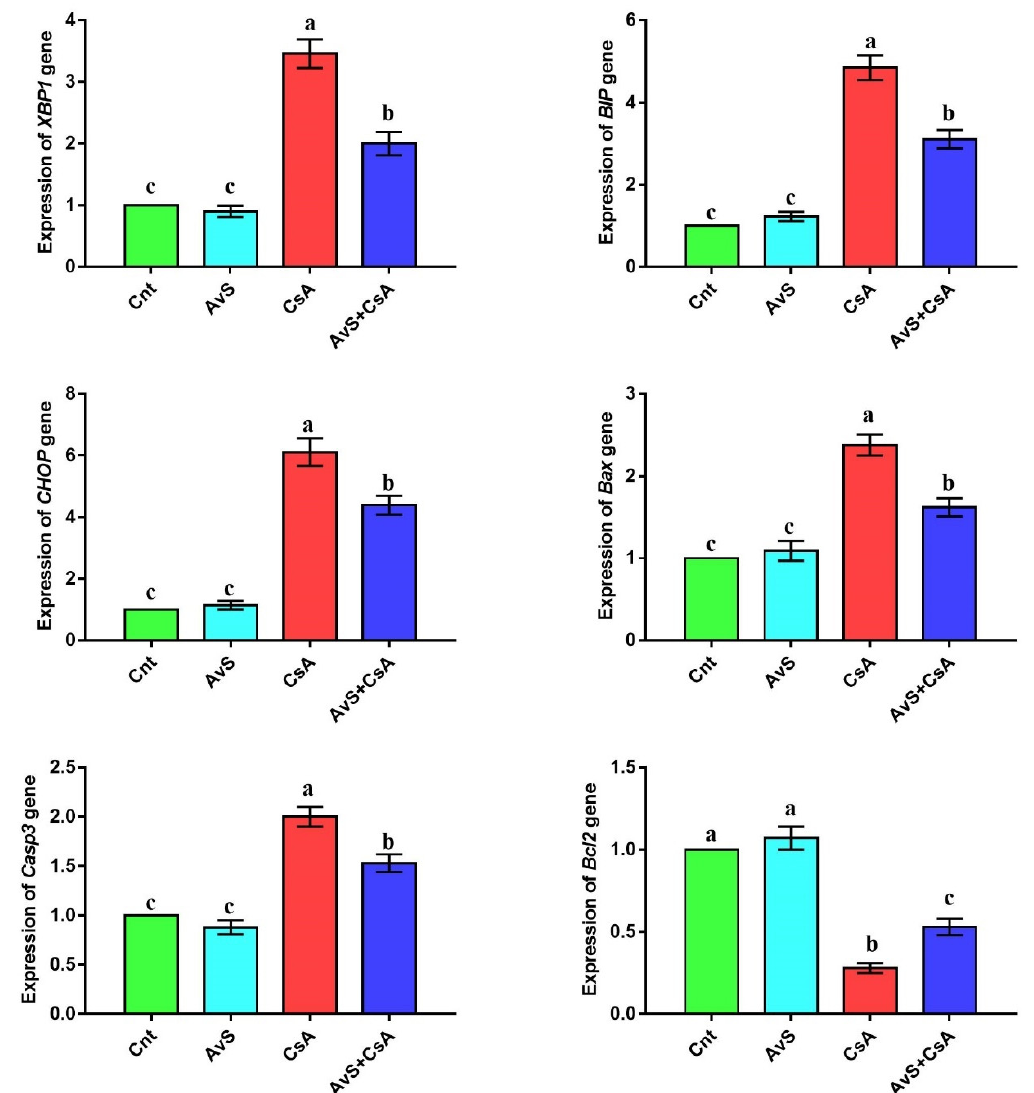
Figure 2. Influence of treatment with AvS and/or CsA on the hepatic expression of ER stress-related genes ( XBP1 , BIP , and CHOP ) and apoptosis-related genes ( Bax , Casp3 , and Bcl2 ), as revealed by real-time PCR. Data were presented as fold change mean ± SEM ( n = 8/group). Columns with different letters (a–c) are significantly different at p < 0.05. All groups were compared to each other.